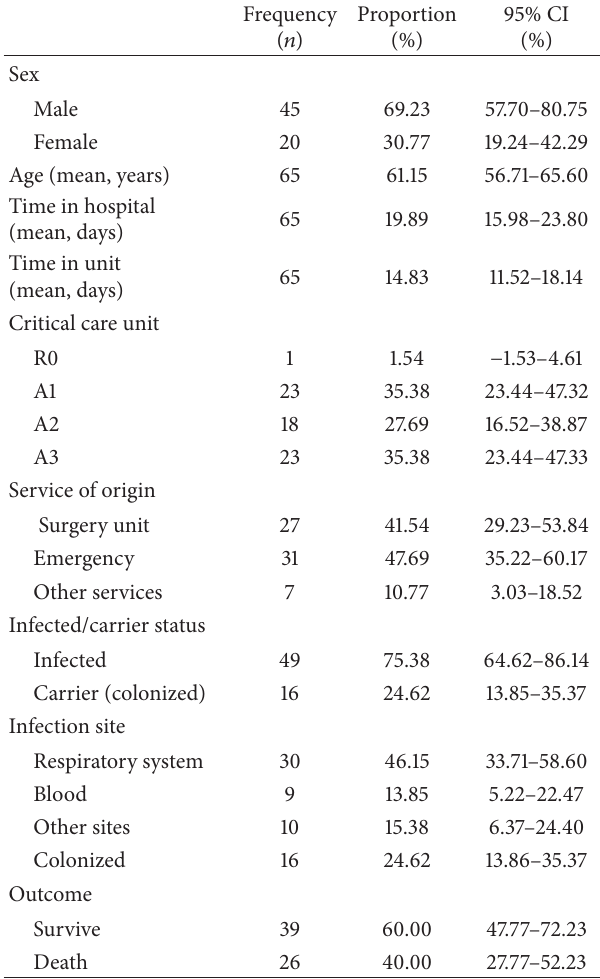
Table 1: Demographic and clinical characteristics of patients involved in the